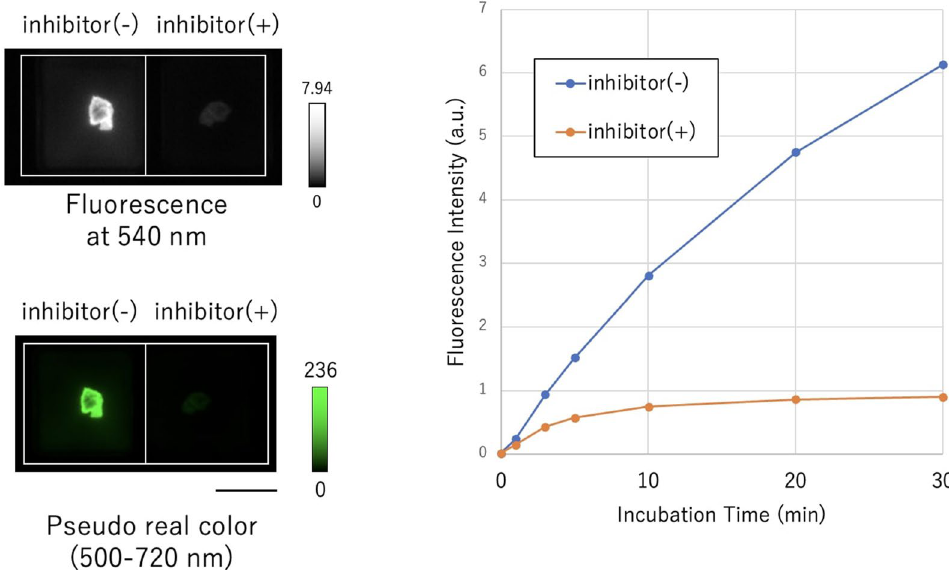
Figure 6. Fluorescence intensity of thymoma tissue in the presence and absence of GGT inhibitor. Fluorescence intensity increased time-dependently in the absence of inhibitor, but the increase was inhibited in the presence of inhibitor. Scale bar, 5 mm. [fluorescent probe] = 50 μM, [GGsTop] = 50